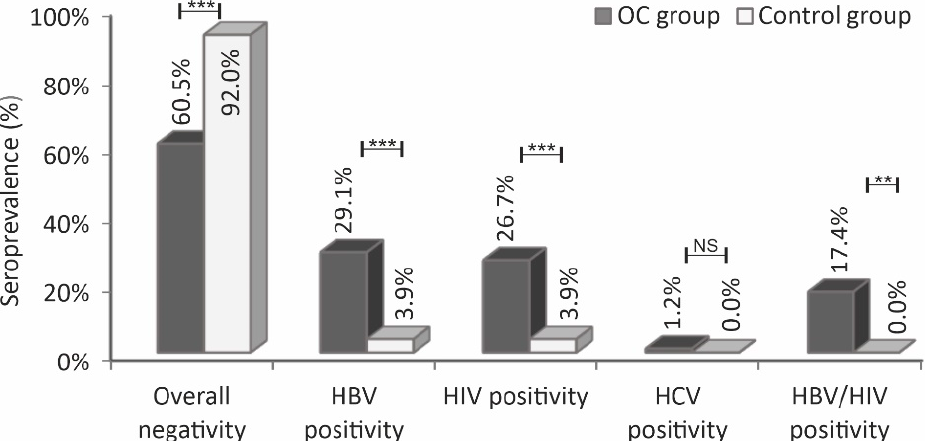
Figure 1. Comparison of HBV, HCV, HIV, and HBV/HIV seroprevalence rates in ovarian cancer patients against the control group and the overall seronegativity (HBV + HCV + HIV) of the OC patients against the control. Statistical significance was indicated as ** p ≤ 0.01 and *** p ≤ 0.001, analyzed by two proportion Z test. Table 2. Association of HBV, HCV, HIV, and HBV/HIV serological status of the participants with age.